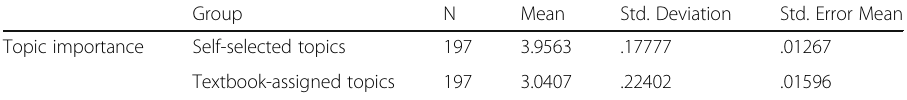
Table 13 The Mean Values of the Learner ’ s Perception of the Textbook-Assigned Topics and Self- Selected Topics Regarding the Topic Importance